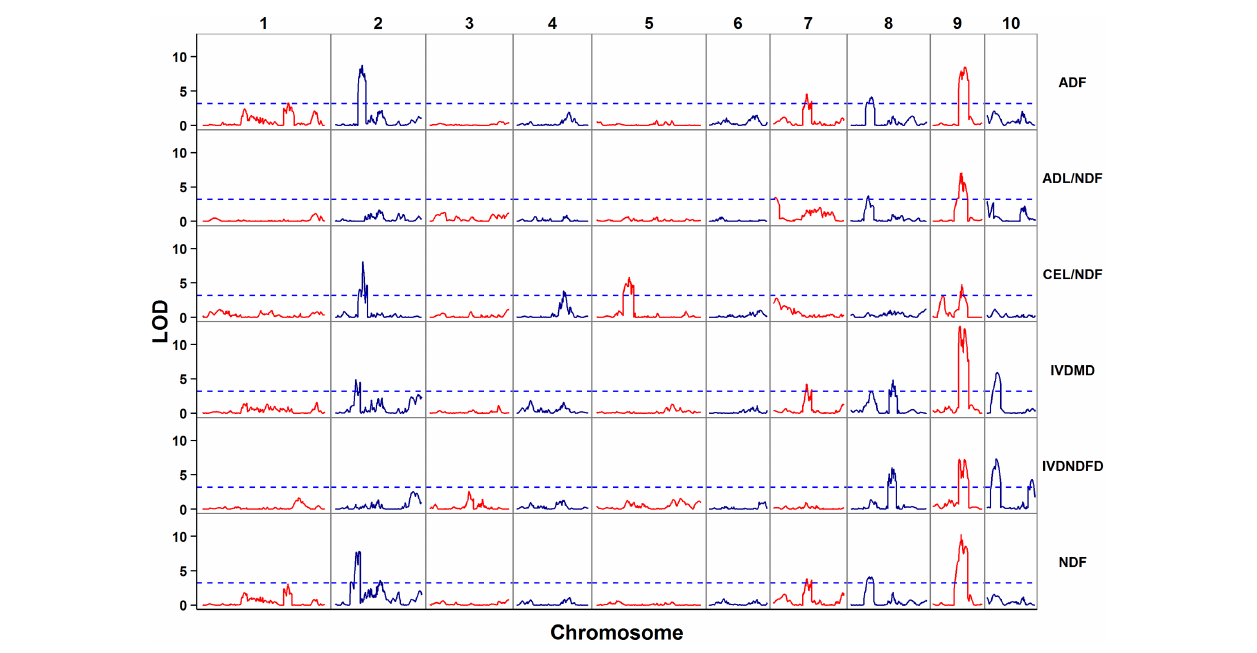
FIGURE 2 | Distribution of putative QTL for cell wall components and digestibility in the RIL population.